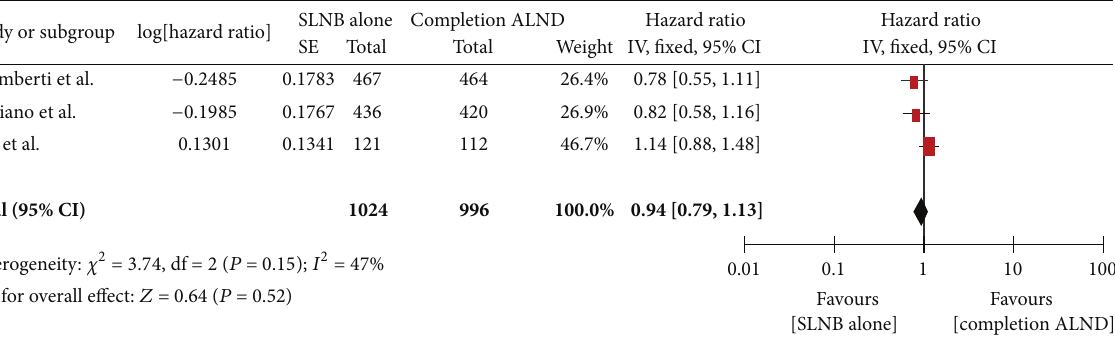
Figure 3: Forest plot showing pooled effect of disease free survival in SLNB alone versus completion ALND in SLN positive breast cancer